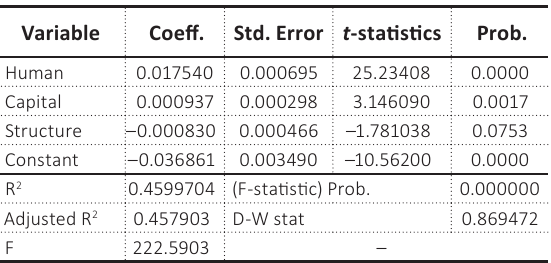
Table 8. Model 2